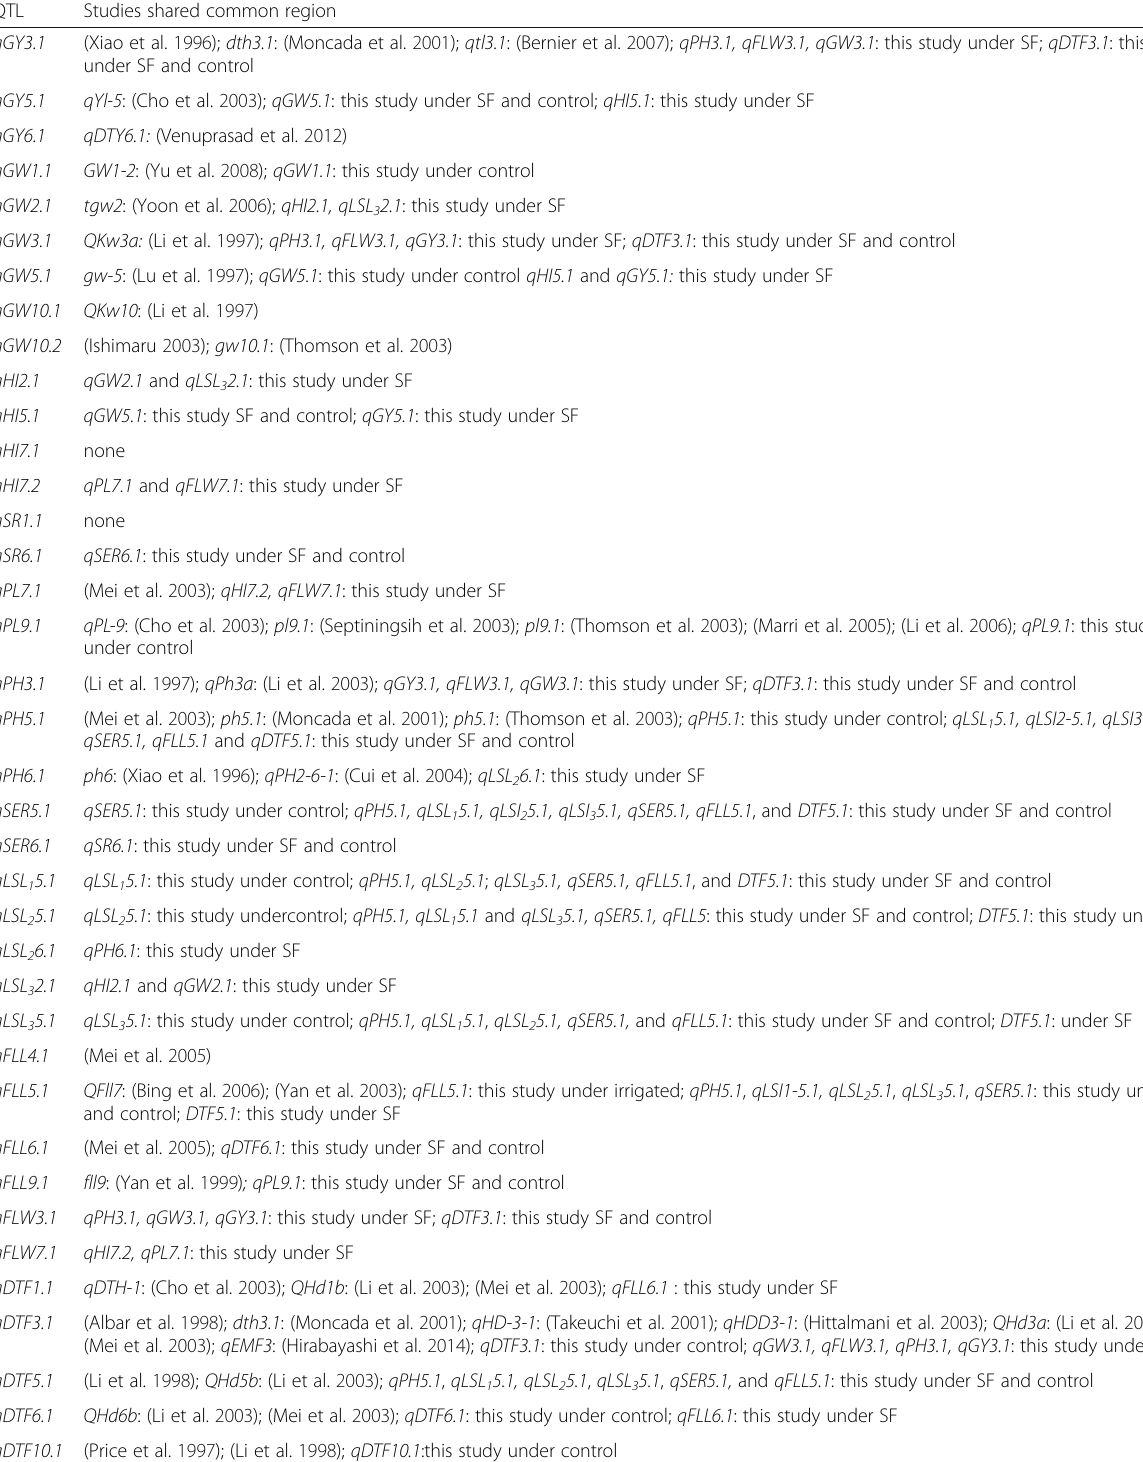
Table 5 Genomic positions of QTLs identified in stagnant flooding with its QTL cluster and comparison to the QTLs identified in control irrigated condition in this study and previously published